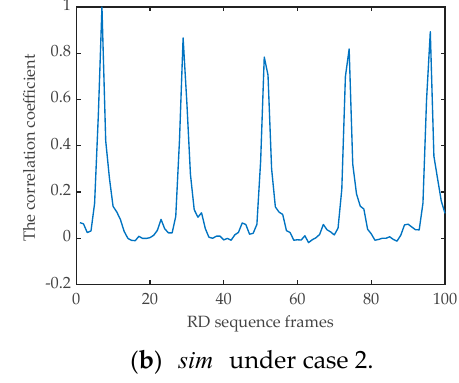
Figure 6. RD sequence similarity estimation.